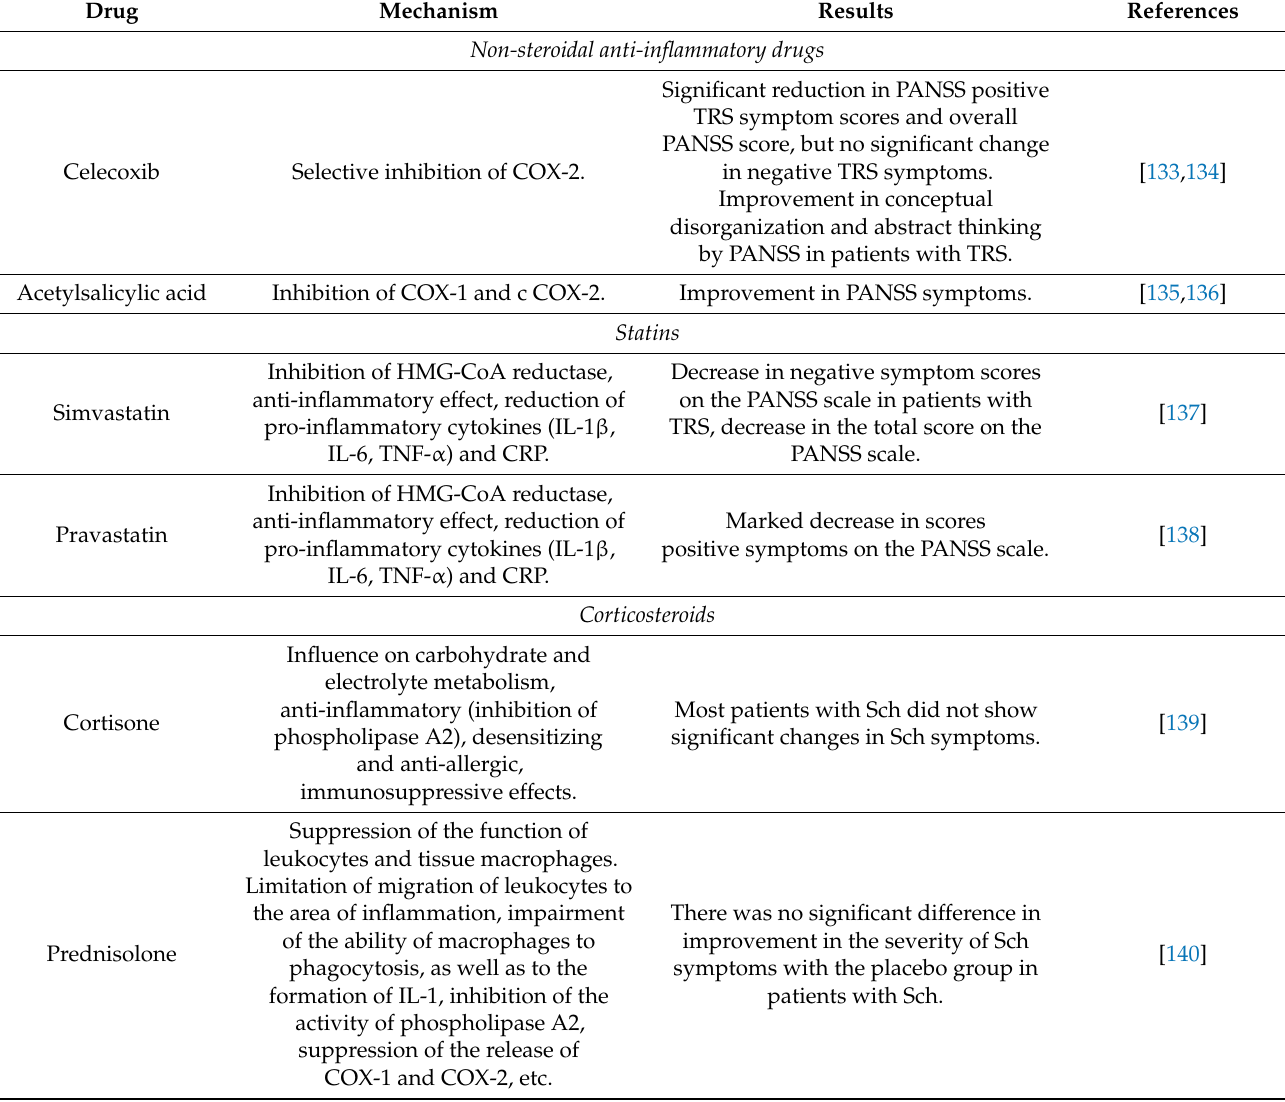
Table 6. Perspective strategies for anti-inflammatory therapy in treatment-resistant